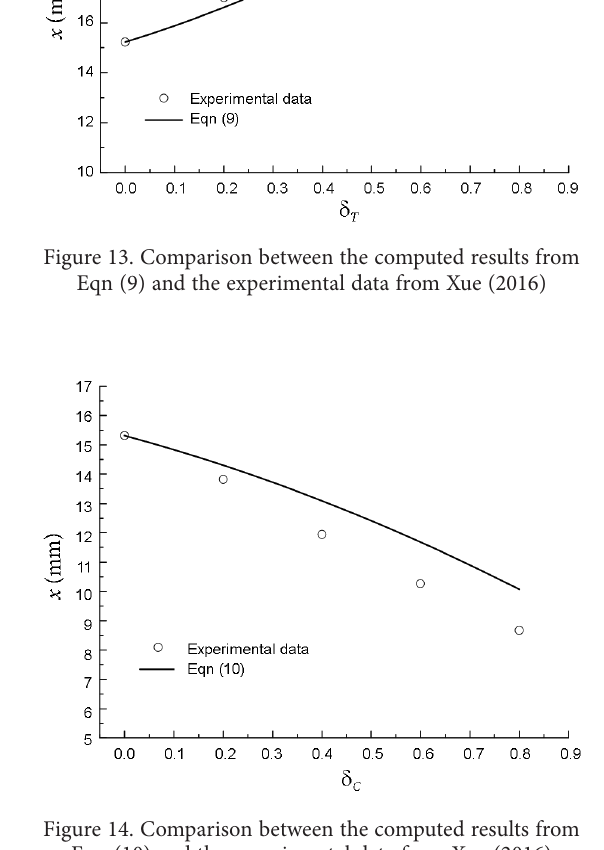
Figure 14. Comparison between the computed results from Eqn (10) and the experimental data from Xue